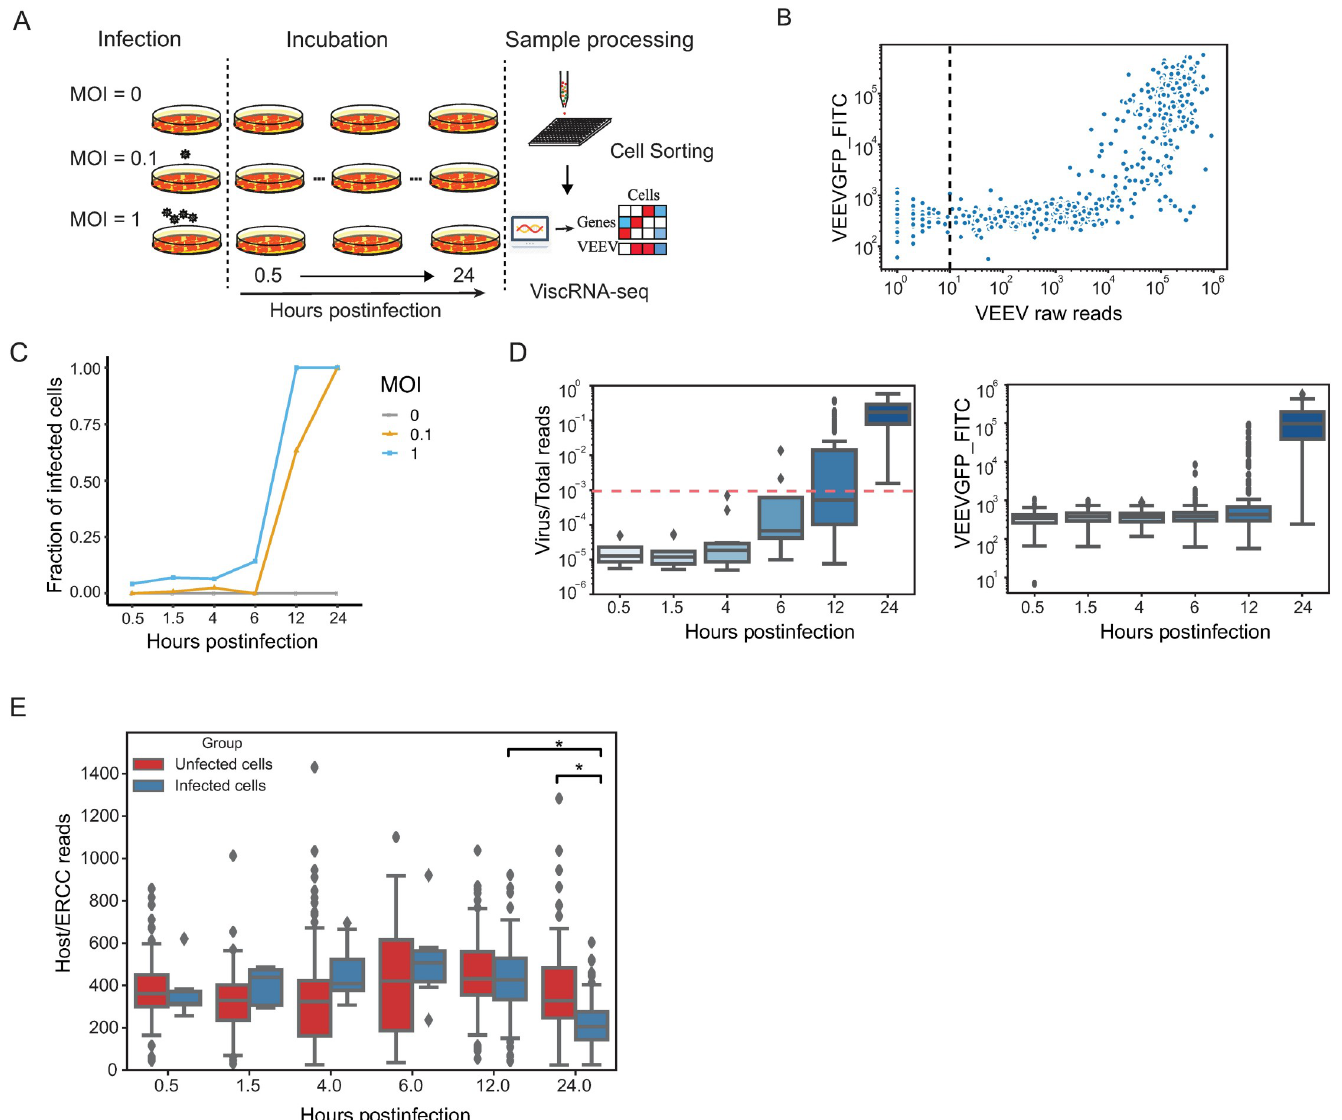
Fig 1. Cell-to-cell heterogeneity during VEEV infection. (A) Schematic of the experimental setup. (B) A scatter plot showing VEEV cDNA sequencing reads and GFP expression measured via FACS (FITC gate) in cells harboring 1 or more viral reads. The dotted line represents the cutoff of infected cells. Cells harboring more than 10 viral reads are considered infected. (C) The fraction of VEEV-TC-83-infected U-87 MG cells over time for two MOIs. (D) Box plots depicting the ratio of virus to total cDNA reads (left) and GFP expression level (right) over time. The horizontal dotted line represents the threshold dividing cells into “low vRNA” and “high vRNA” harboring cells (see text). (E) Box plots showing host cDNA to ERCC read ratio in infected and uninfected cells derived from different time points postinfection. � p < 0.05 by Mann-Whitney U test. MOI, multiplicity of infection; ERCC, External RNA Controls